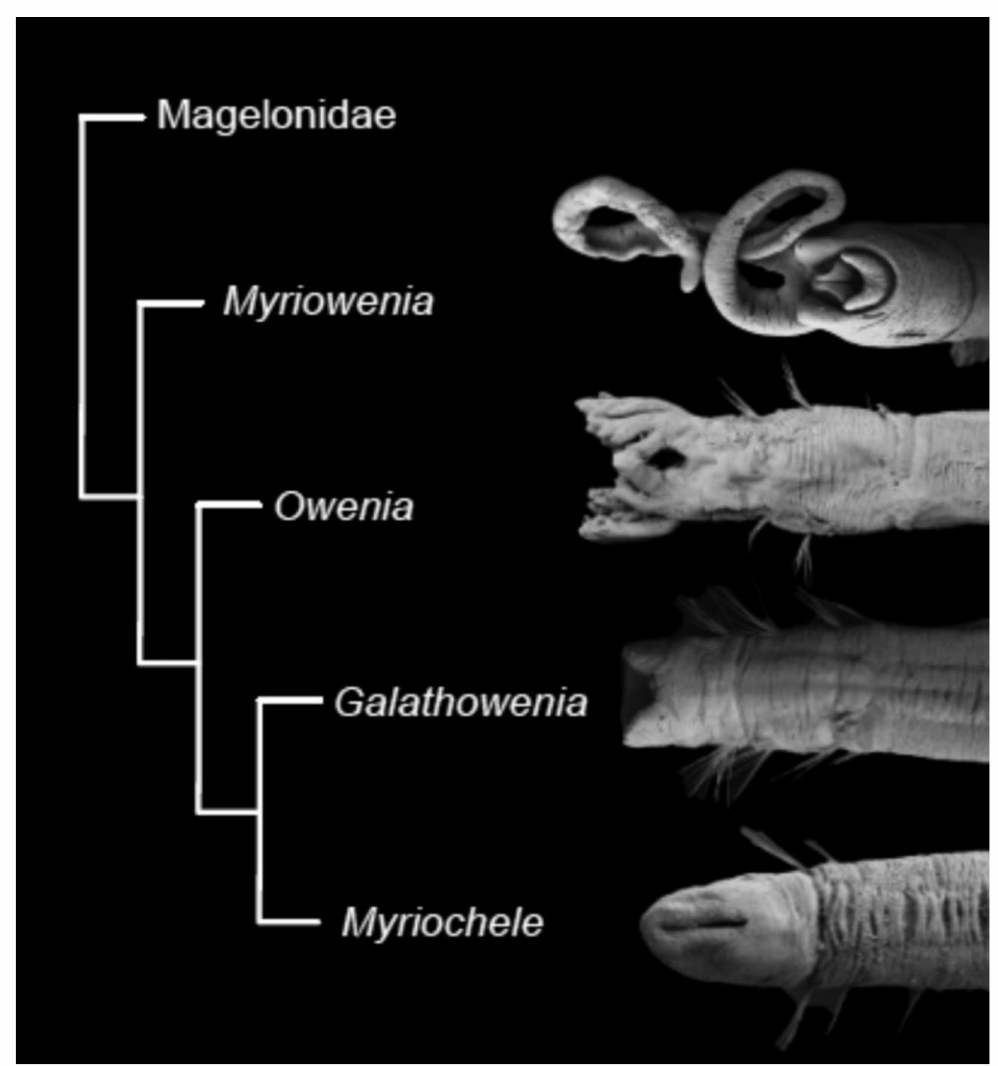
Figure 11. Phylogenetic hypothesis, based on morphological data, of relationships between oweniid genera. Modified after Capa et al.